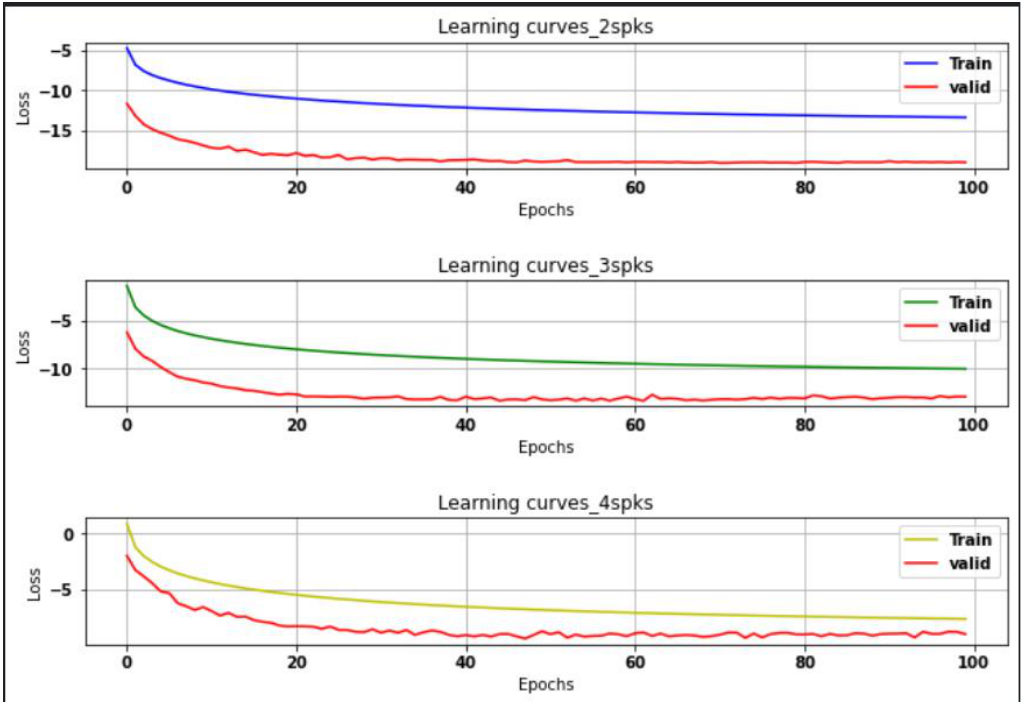
Figure 6. Training curves of our model for various numbers of speakers N = 2, 3, 4. Table 1. SI-SNRi for different numbers of mixed speakers.